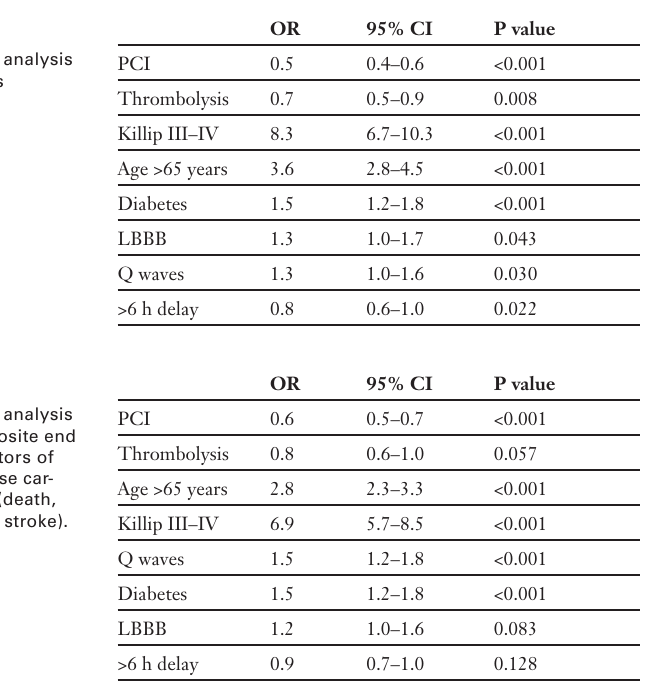
Table 3 Multivariate analysis of predictors of death.